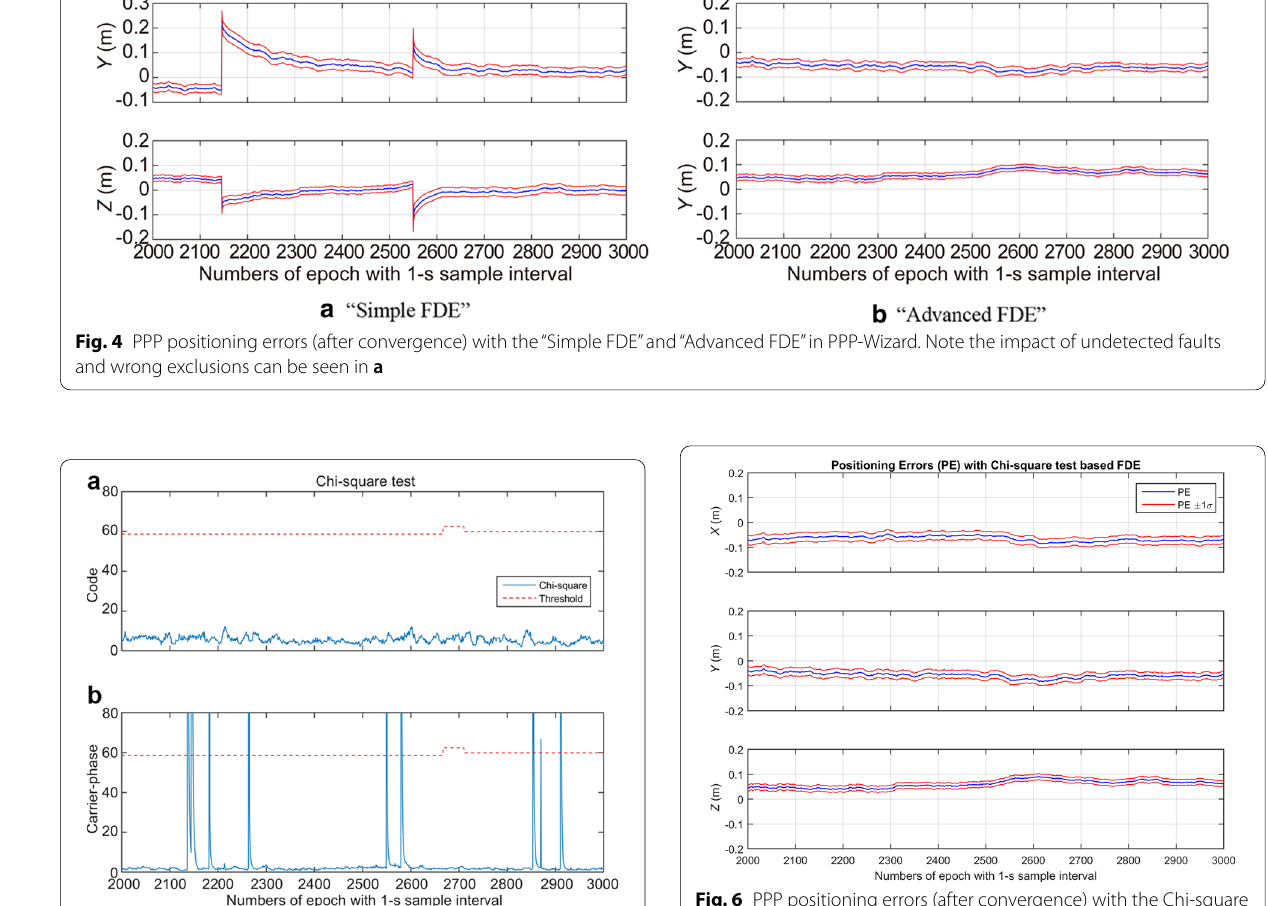
Fig. 5 Chi‑square test statistics for code and carrier‑phase measurements for fault detection; P FA